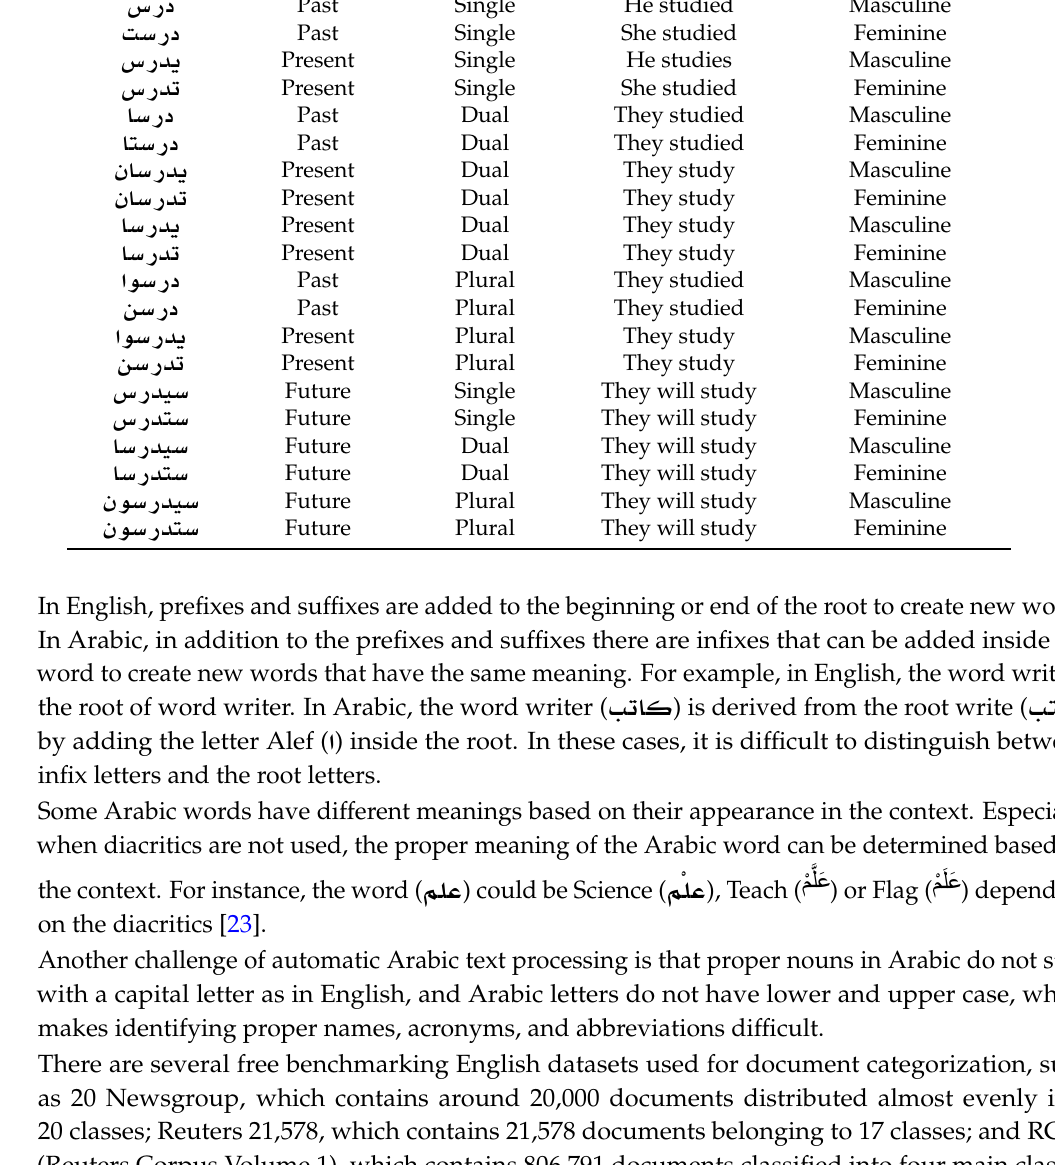
Table 3. Different morphological forms of word study ( سرد ).